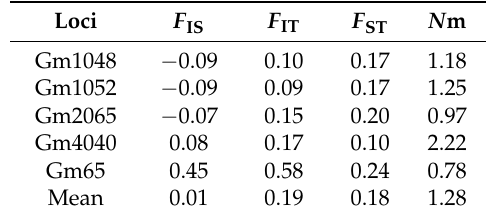
Table 7. F -statistics and N m of Erythrophleum fordii populations. Loci F IS F IT F ST N